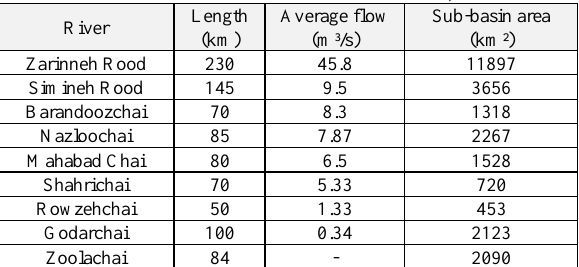
Table 1. Main river inflows to Lake Urmia (Ghaheri, et al. 1999)